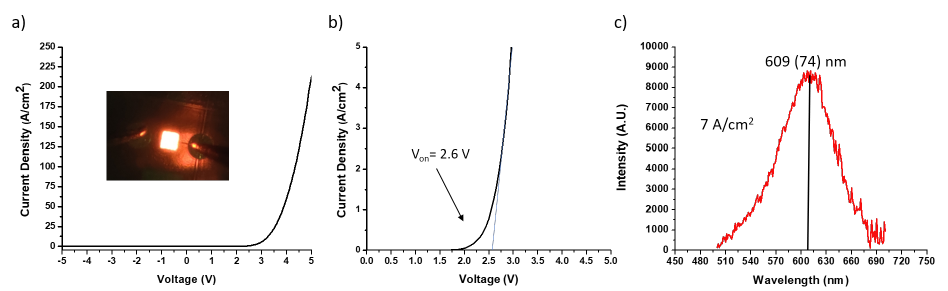
Figure 2. ( a ) Current density-voltage (JV) behavior for fabricated device from − 5 V to 5 V with inset optical image of device electroluminescence at 20 A/cm 2 . ( b ) The same JV curve focused on low-current-density regime; turn-on voltage indicated. ( c ) Electroluminescence (EL) emission spectra of device operating at 7 A/cm 2 with peak wavelength and FWHM identified.